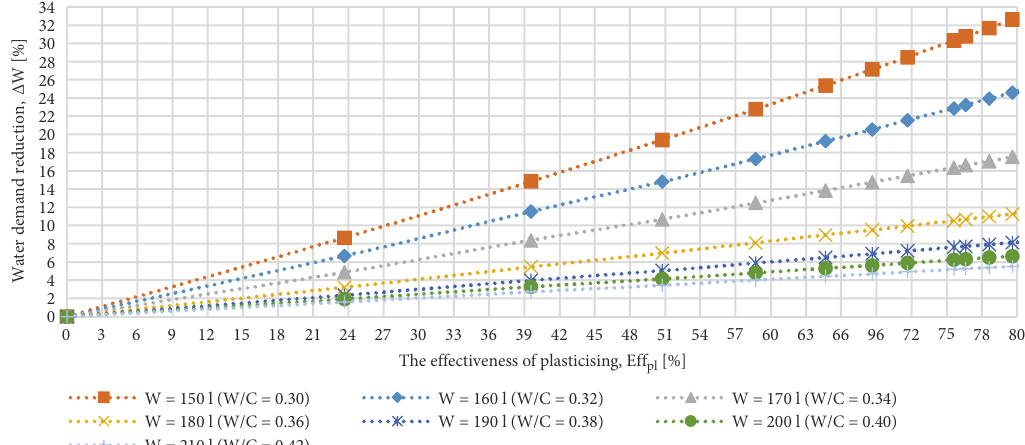
Figure 8. Diagram for the determination of water demand for mixtures of equivalent viscosity in different water content (the ratio of W/C)